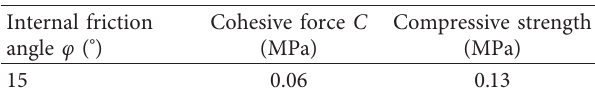
Table 3: Joint plane